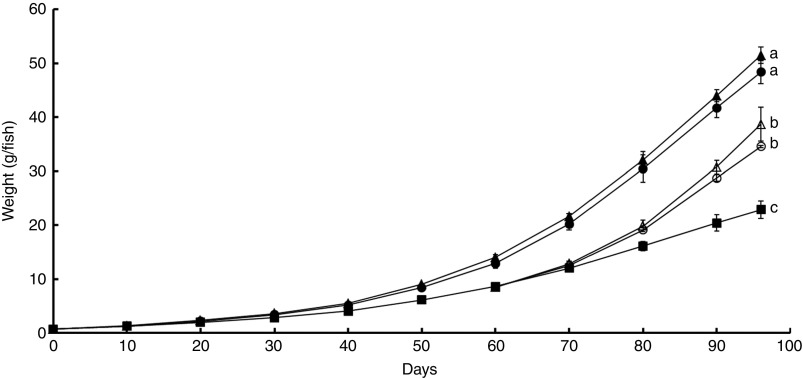
Mean weight (g/fish) of rainbow trout at each sampling time point over the 60-d
pre-experimental period and the 36-d experimental period. Values are means
(n 3 except sunflower oil-based diet (SO) treatment from starting
day until day 60 for which n 9), with their standard errors. The
fish weight was impacted by the dietary treatment regarding the lowest weight of
fish fed SO (■) and the highest weights of fish fed on linseed oil–based diet (LO,
●) or fish oil-based diet (FO, ▲) during 96 d. Intermediate fish weights were
reported when feeding fish on SO for 60 d and then on LO (SO/LO, ○) or FO (SO/FO, Δ)
for 36 d. a,b,c Mean values with unlike superscript letters were
significantly different (Tukey’s post hoc test, α
5 %).